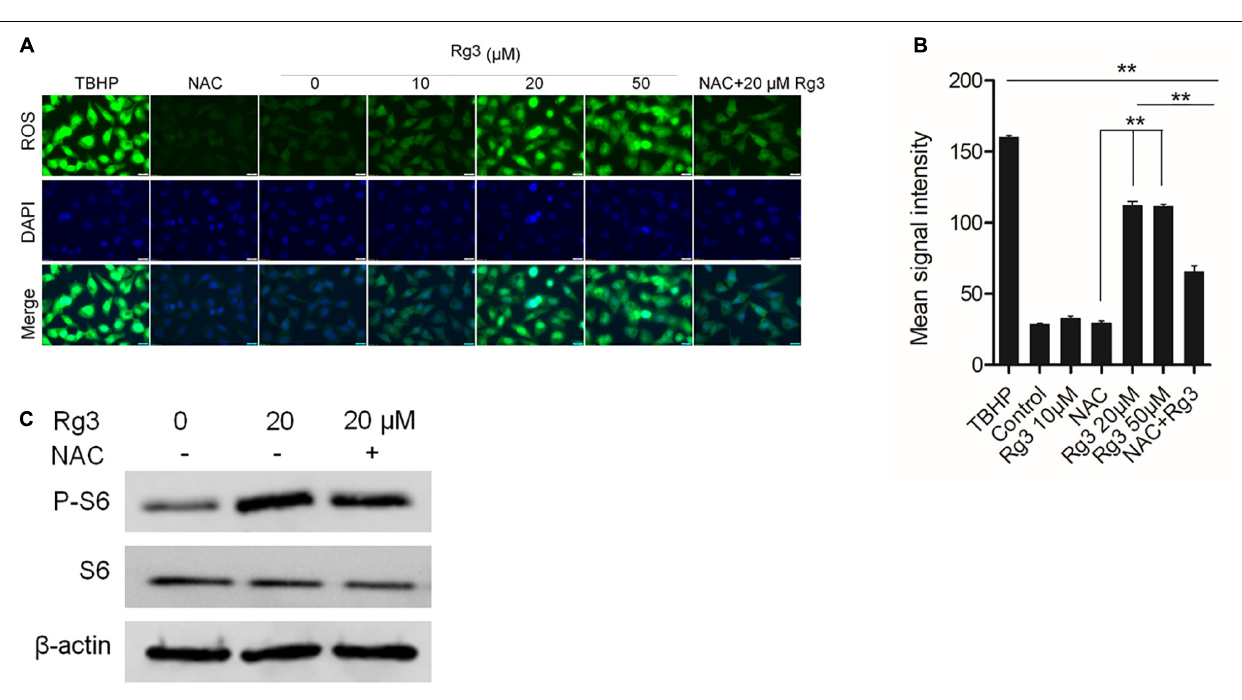
FIGURE 4 | Rg3 stimulates mTORC1 independent of reactive oxygen species (ROS). (A) Effect of Rg3 on ROS production. Cells were starved in 0.5% of FBS for 24 h followed by treatment with different concentrations of Rg3 for 1 h. N-acetyl cysteine (NAC) (50 µ M) was added to the control and 20 µ M Rg3 treated wells. Scale bar, 20 µ m. (B) Quantitation and statistical analysis of oxidative stress based on staining with CellROX R (cid:13) Oxidative Stress Reagents. Data are from three independent experiments and expressed as mean ± SD. ** P < 0.01. (C) Cells were pretreated with 50 µ M NAC (+) or vehicle control (–) for 10 min followed by treatment with Rg3 for 1 h. mTORC1-dependent phosphorylation of S6 was determined by Western